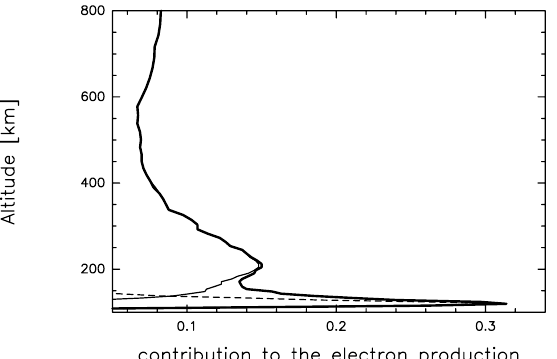
Fig. 5. Linearity check of the impact of the He II and C III lines on the electron production rate. The thick full lines represent the sum of the contributions of He II and C III, the thin line the contribution of He II and the dashed line the contribution of C